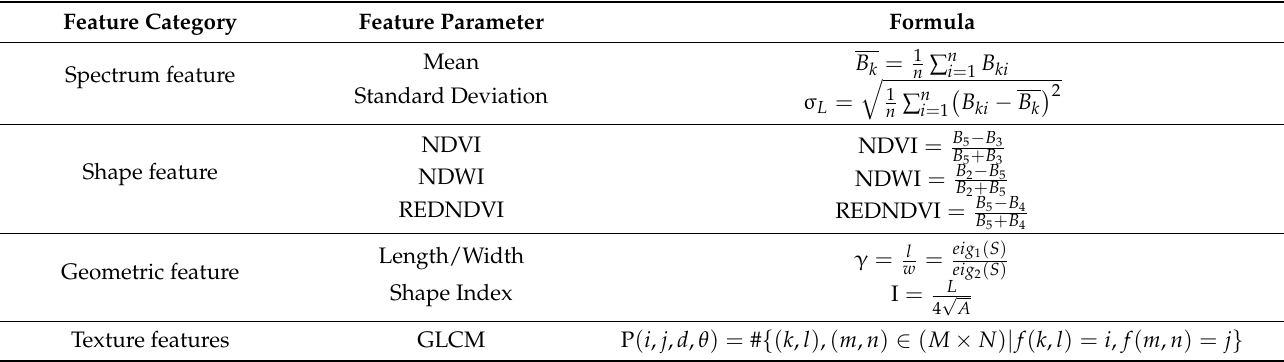
Table 2. Calculation formula of feature parameter.